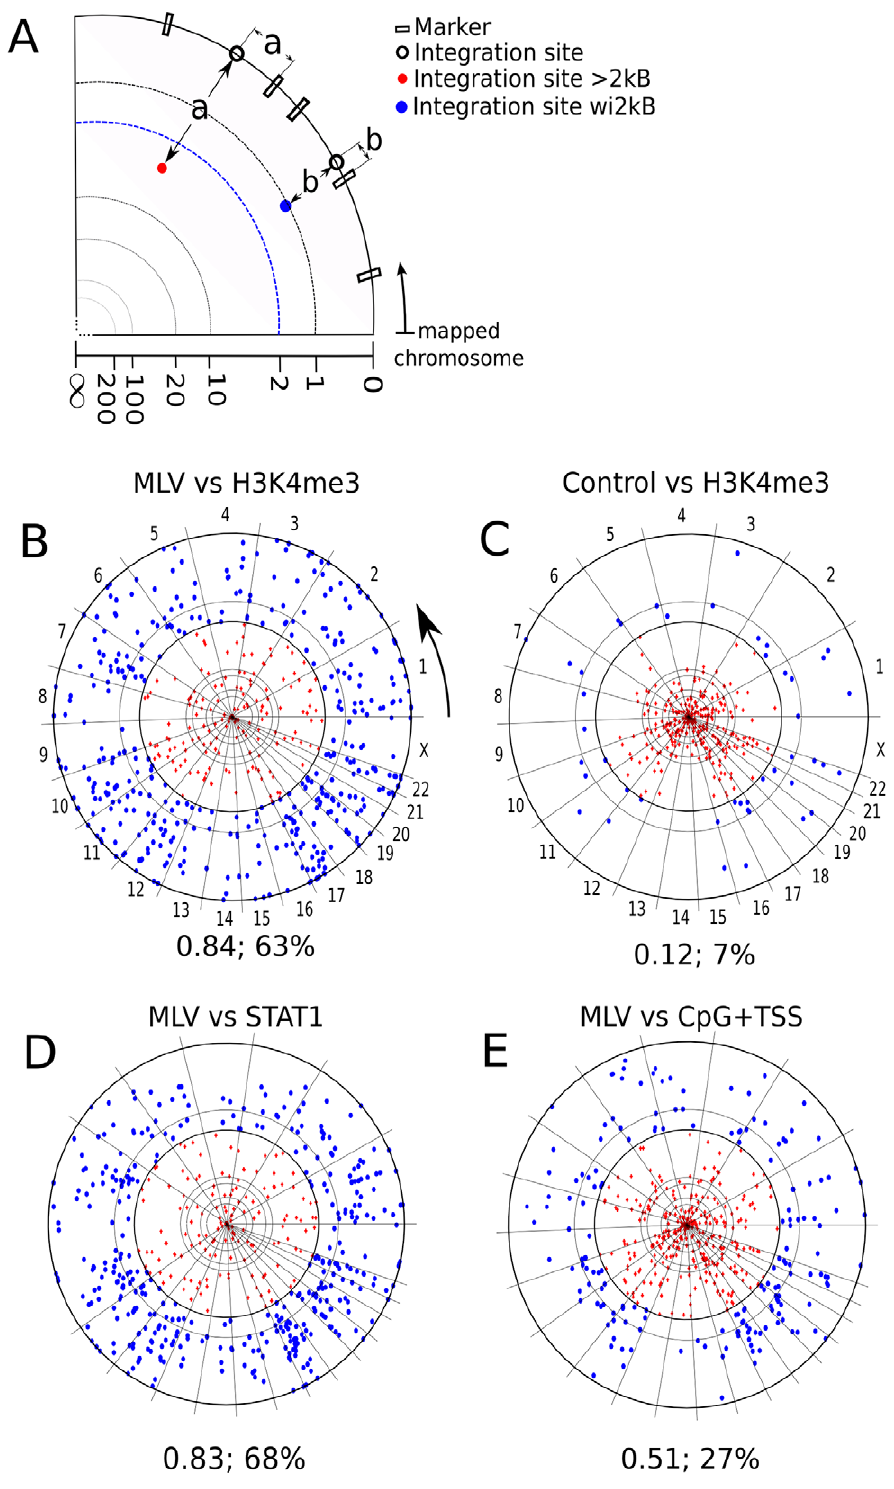
Figure 1. Visualization of association between retroviral integration sites and chromosomal markers. ( A ) Construction of chromosome projection mandalas to visualize the proximity of individual proviruses to the nearest marker on the chromosome. The linear sequence of each human chromosome was linked and circularized. Proviral integration sites were located on the circle according to their position on each chromosome (empty circles) and then a marker (filled circles) was placed towards the center of the circle, at a distance from the perimeter that was equal, in log scale from 0 to 1 megabase, to the distance from the closest marker (empty boxes). Blue filled circles represent proviruses that were within 2kB from the nearest marker; red circles represent proviruses that are . 2kB from the nearest marker. Examples of chromosome projection mandala for ( B ) MLV (Lewinski et al. 2006) versus H3K4me3, the arrow indicates the chromosomal mapping direction ( C ) Control versus H3K4me3 ( D ) MLV versus STAT1 and ( E ) MLV versus CpG + TSS. The number of MLV proviruses analyzed in this dataset (Lewinski et al. 2006) was 588. The F score and the percentage of proviruses within 2 kB are presented under each mandala.